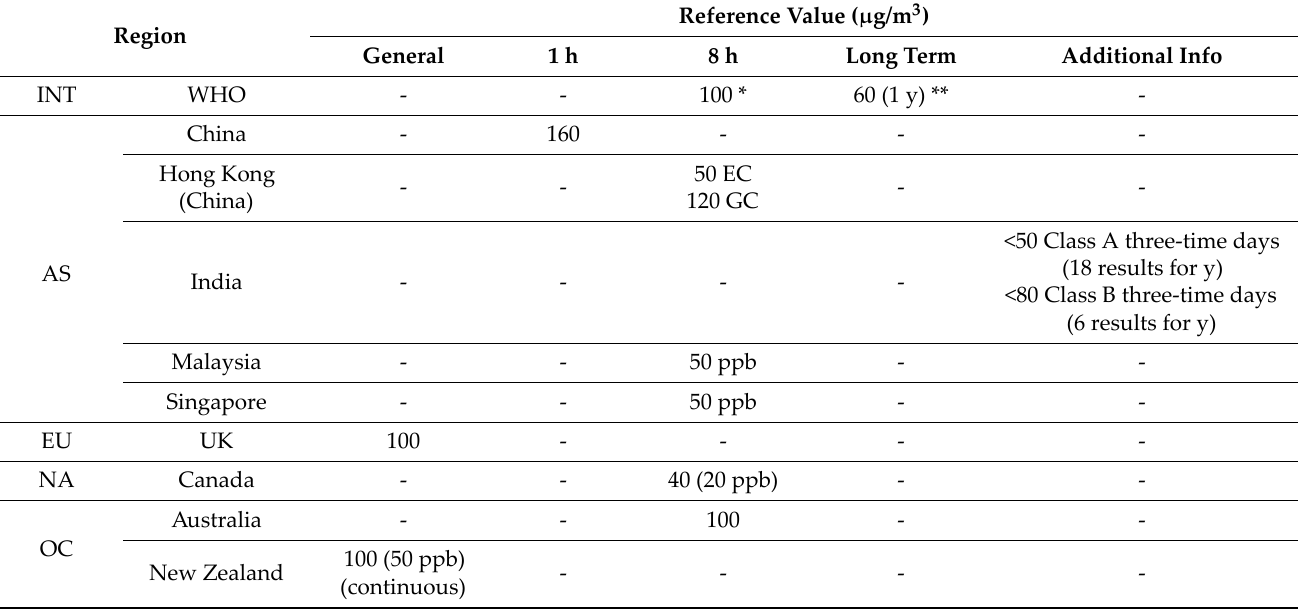
Table 12. Reference values for